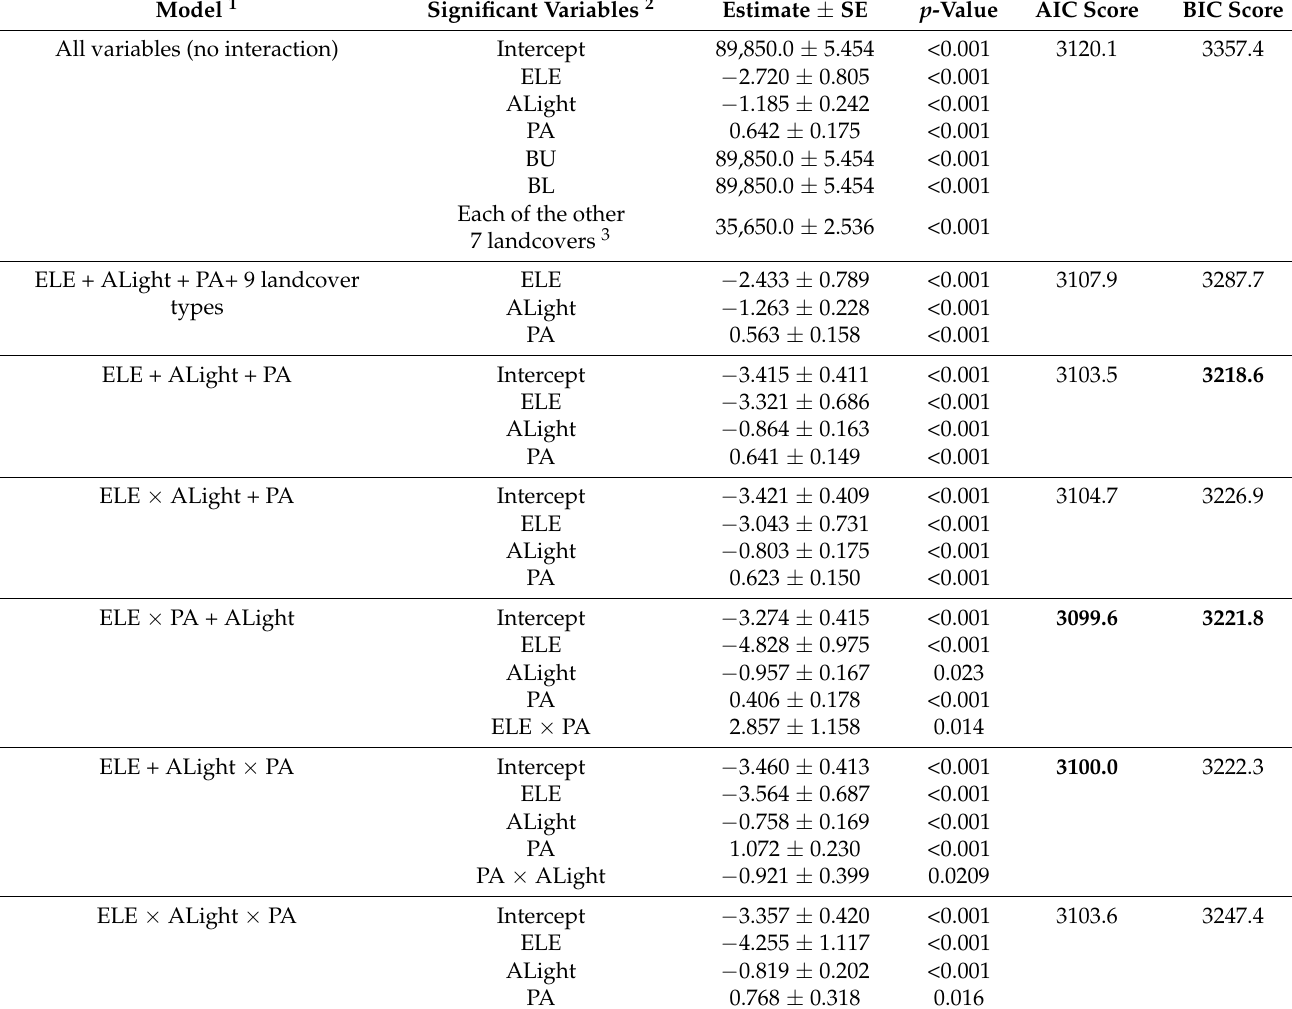
Table 3. Evaluation results of seven generalized linear mixed models (GLMM) models with selected landscape features using Akaike information criterion (AIC) and Bayesian information criterion (BIC) criteria. In model formula, a cross sign denotes that an interaction of the prior and posterior variables is considered, whereas a plus sign denotes that interaction is not considered. Variable abbreviations—ELE, ALight, PA, BU, and BL stand for the mean elevation, artificial light intensity, presence of protected area, bushland, and bare land. In AIC and BIC scores, numbers in bold indicate the two smallest values among all results in either